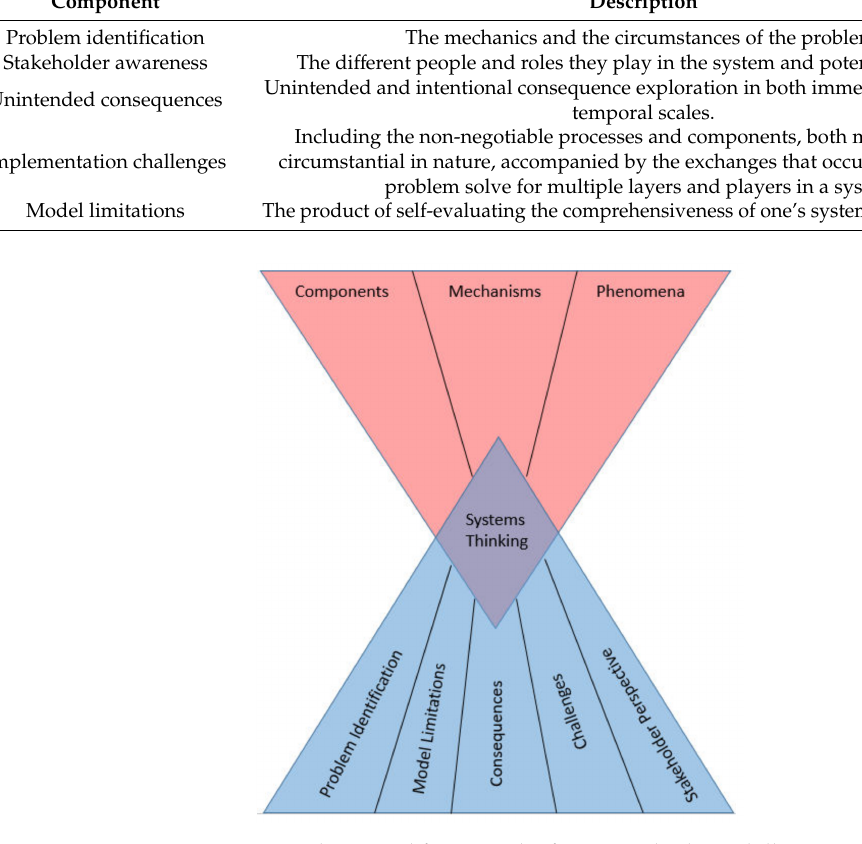
Figure 1. Theoretical framework of systems thinking